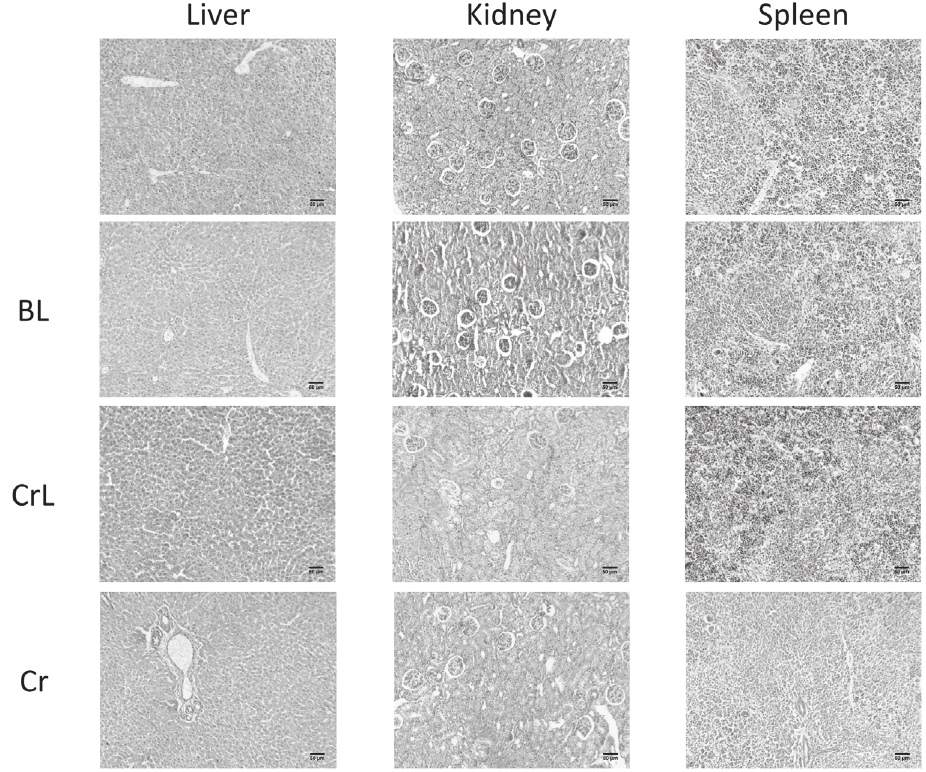
Figure 3 - Histological analysis of liver, kidney and spleen of treated rats. Negative Control (NC), Blank Liposomaes (BL), Creatine Liposomes (CrL), Creatine